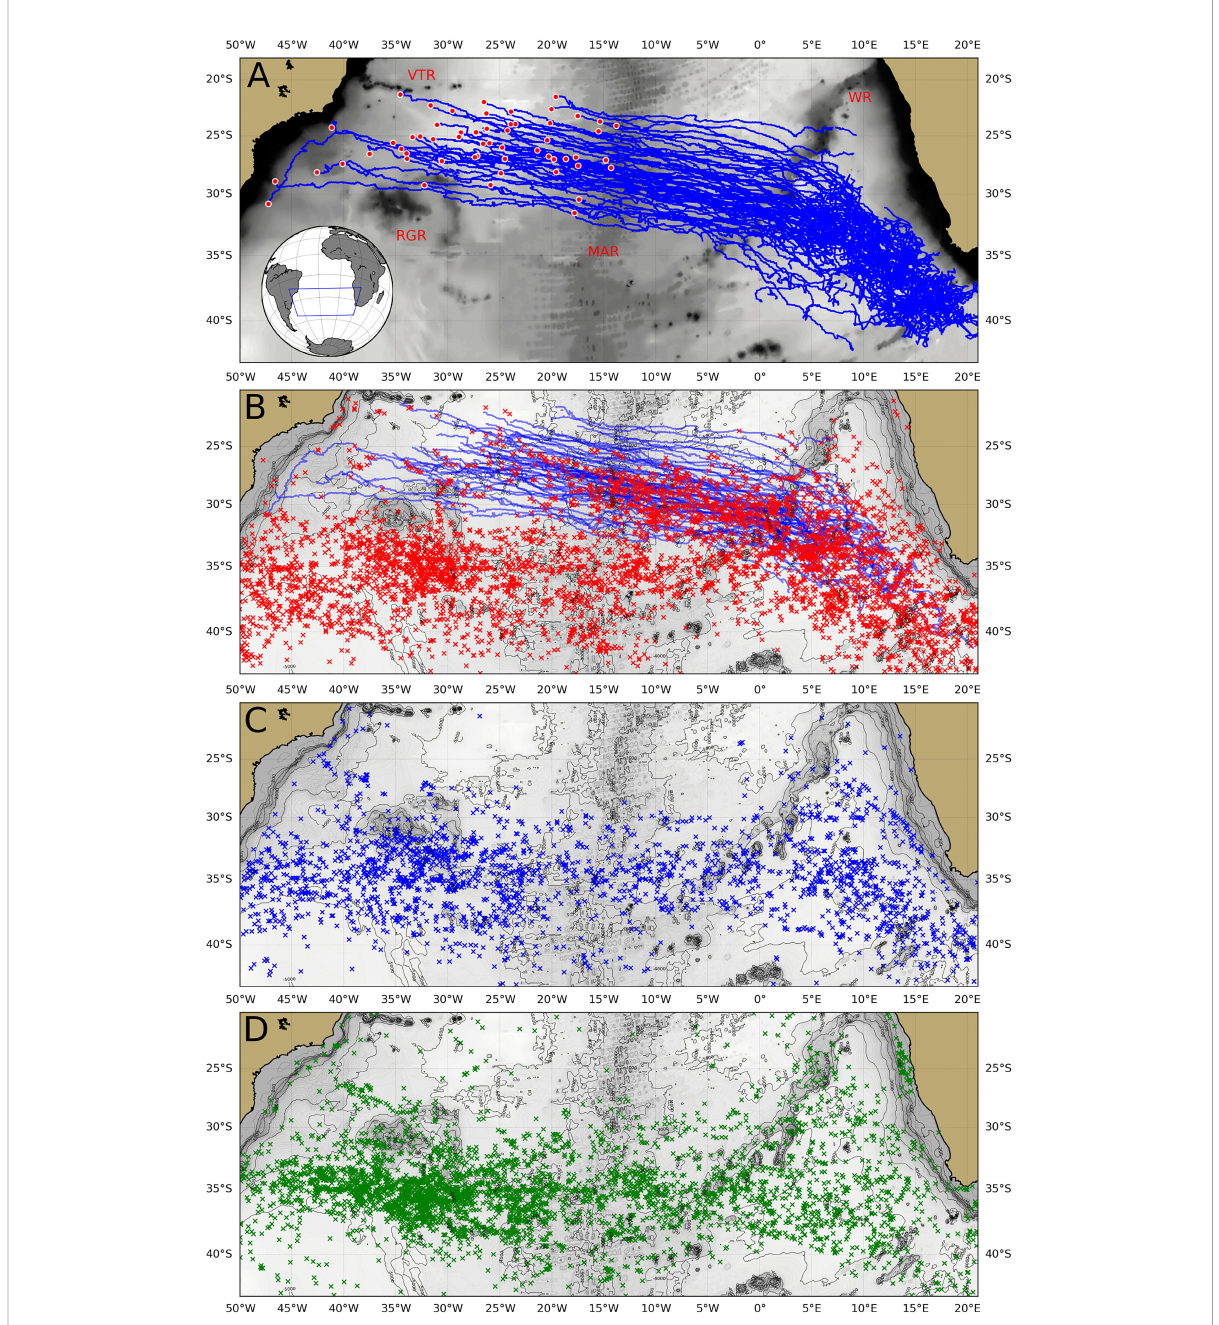
FIGURE 1 (A) Tracks of 56 long-lived Agulhas rings (blue lines) between 1993 and 2016 identi fi ed using an automatic algorithm. The set includes only the rings that reached the western basin. The acronyms WR, MAR, VTR, and RGR refer to Walvis Ridge, Mid-Atlantic Ridge, Vito ́ ria-Trindade Ridge, and Rio Grande Rise, respectively. The red circles mark the fi nal tracking position of each ring. The bottom topography is shown in the background in gray. (B) Map with the paths of the Agulhas rings (blue lines) and the sites of detection of thermostads coincident with anticyclones (red x). (C) Map with the sites of detection of thermostads coincident with cyclones (blue x). (D) Map with the sites of detection of thermostads in pro fi les outside eddies (green